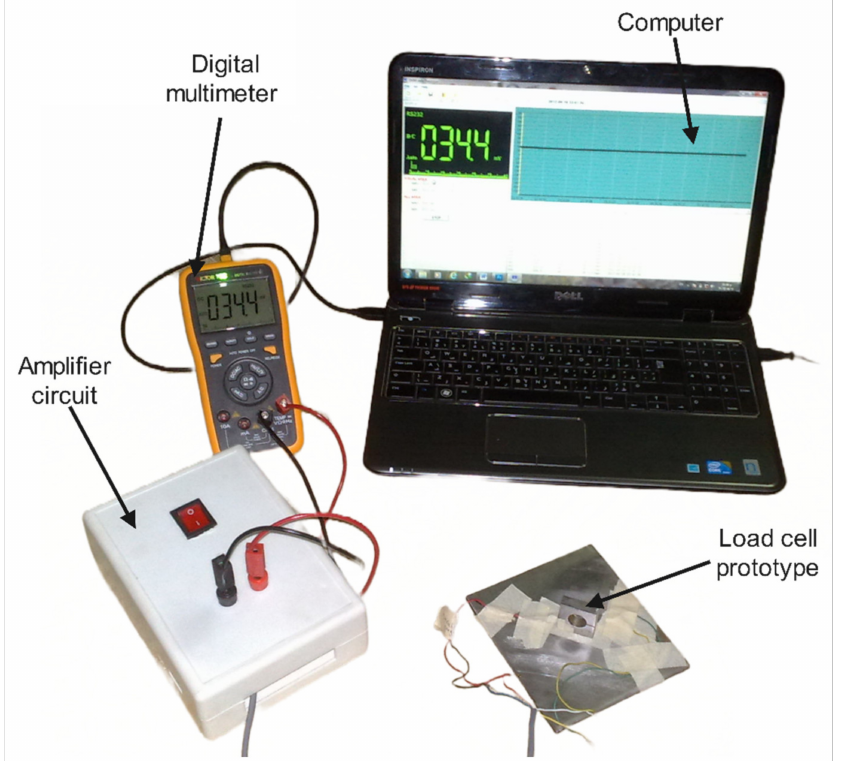
Figure 15. Experiment platform for load cell